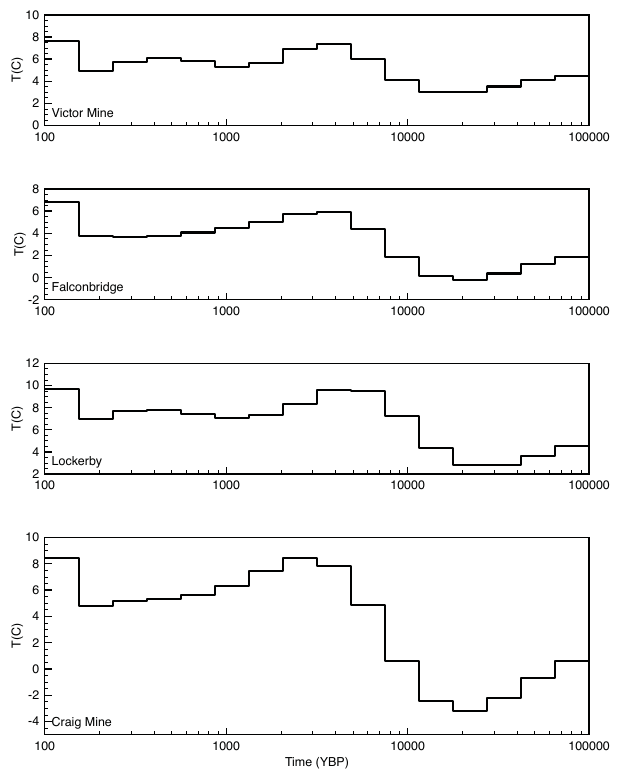
Figure 6. Ground surface temperature history for all the boreholes around Sudbury, Ontario (Victor Mine, Falconbridge, Lockerby, and Craig Mine).The temperatures have been shifted with respect to the reference surface temperature of the site, T o , as shown in Table 2.